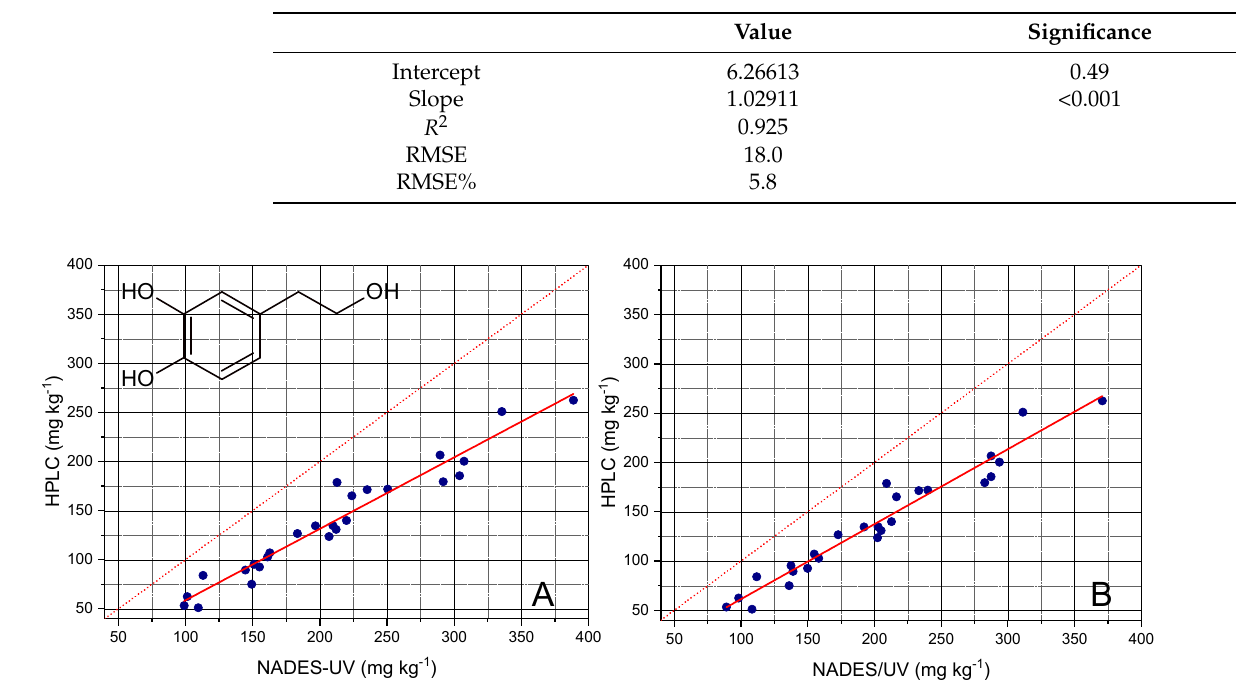
Table 2. Parameters of the regression analysis of total Tyr determined by NADES-UV versus total Tyr determined by acid hydrolysis and HPLC.